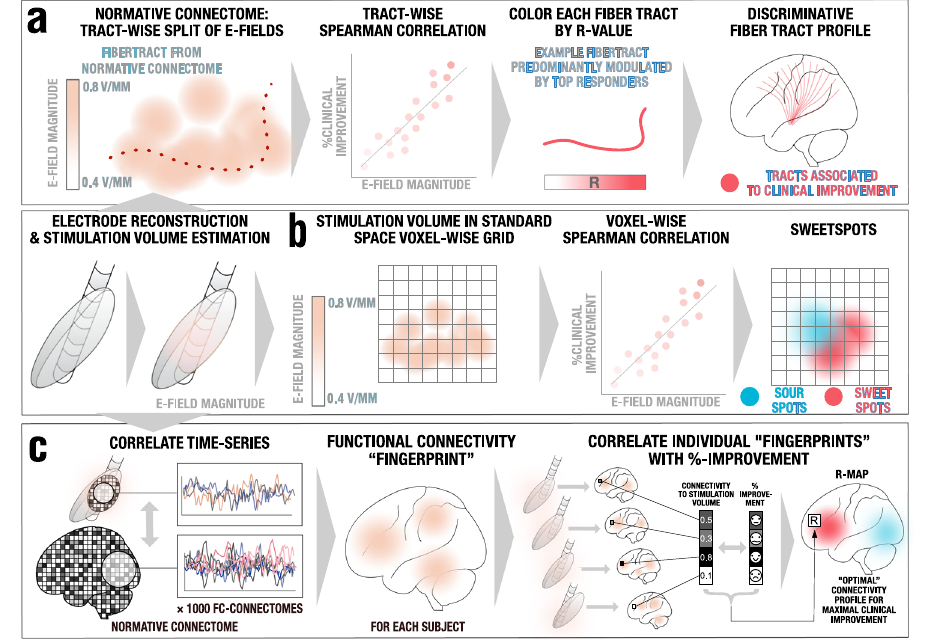
Fig. 1 | Overview of the three methods applied. A pre-requisite to run these analysesistoreconstructtheelectrodetrajectoryandlocalizationtothenestimate the stimulation volume following the fi nite element method (FEM). a DBS fi ber fi ltering. Stimulation volumes as E- fi elds were pooled in standard space and overlaid on an ultra-high resolution normative connectome 43 . Peak E- fi eld magni- tudesalongeachtractwereaggregatedforeachstimulationvolumeandSpearman rank-correlated with clinical outcomes. This led to weights that were assigned to each fi bertract. b DBS Sweetspot mapping. For each voxel, the E- fi eld